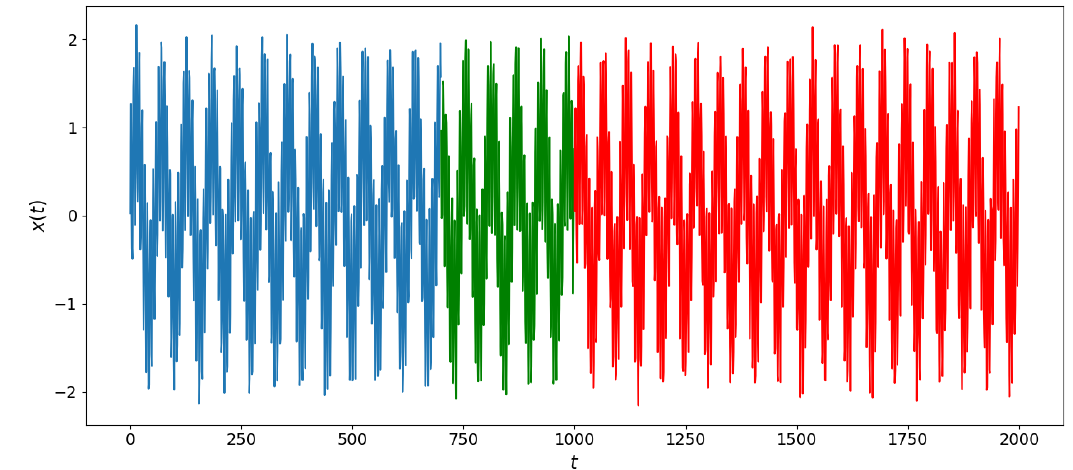
Figure 8. Simulated sinusoidal signal with parameter change occurring in the red region.